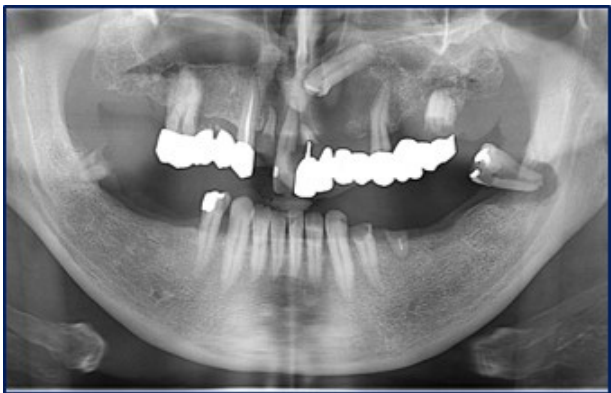
Figure 2. Panoramic radiogram showing an osteolytic lesion of the left anterior maxilla with undefined borders, involving the periodontal ligament of 2.1 and 2.4 as well as the retained 2.3 tooth.